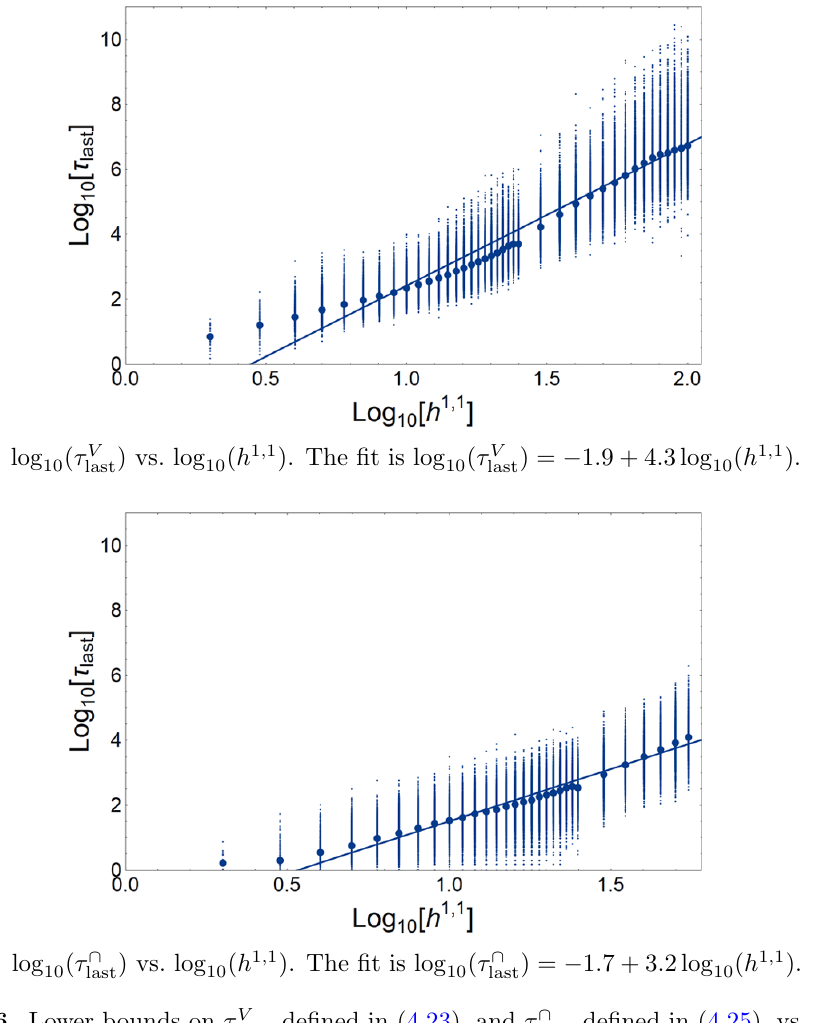
Figure 6. Lower bounds on (cid:28) V